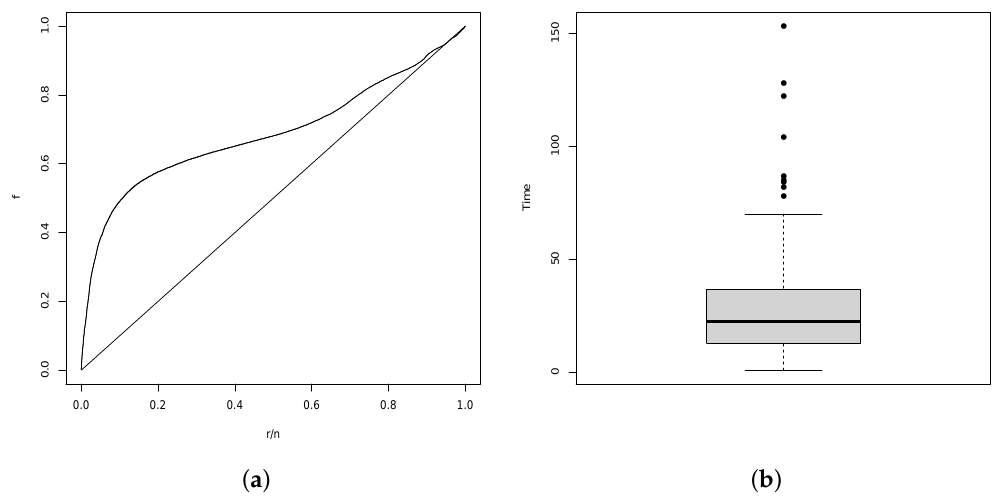
Figure 2. ( a ) TTT Plot and ( b ) boxplot of times.